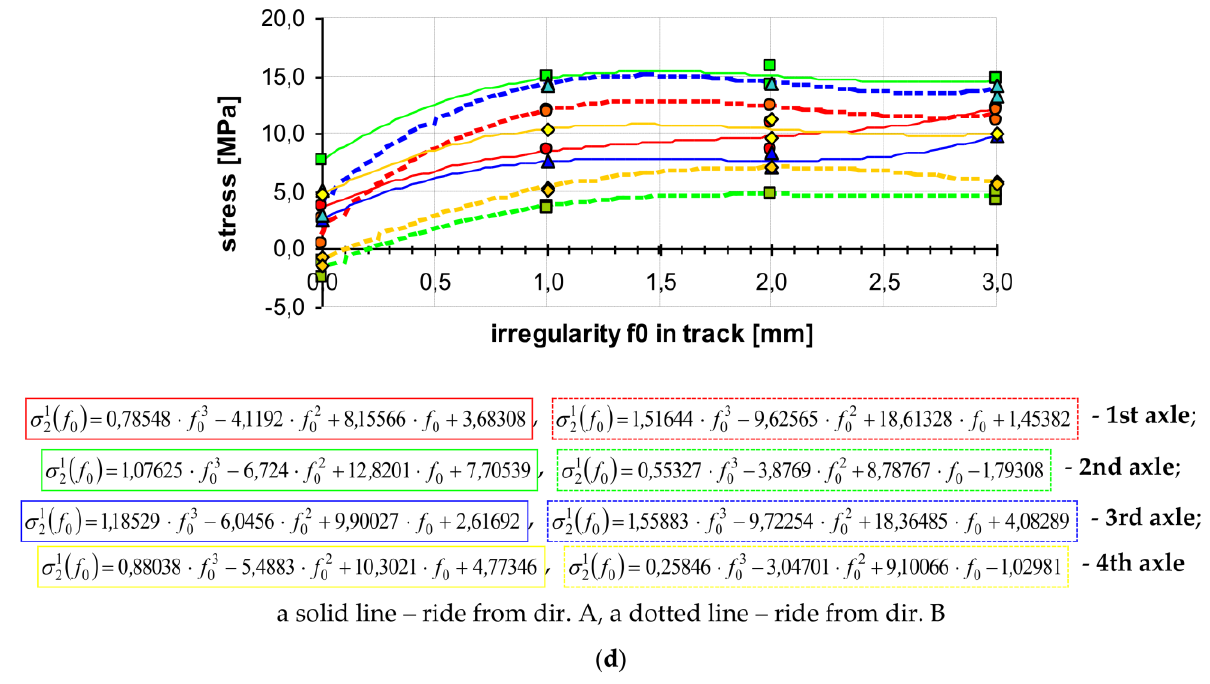
Figure 10. A dependence on changes in rail stresses on the value of f 0 -induced irregularity in the railway track (the loads from the locomotive’s succeeding axles—a scheme from Figure 3). Measurement of stresses on the particular extensometers (Figure 5b): ( a ) the stresses in the rail foot in section no. 2 from a force in section no. 2 (the succeeding axles); ( b ) the stresses in the rail foot in section no. 1 from a force in section no. 1 (the succeeding axles); ( c ) the stresses in the rail foot in section no. 2 from a force in section no. 1 (the succeeding axles); ( d ) the stresses in the rail foot in section no. 1 from a force in section no. 2 (the succeeding axles).